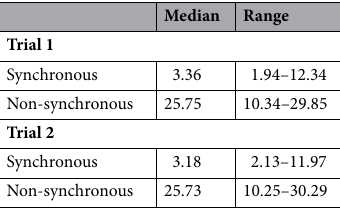
Table 6. Descriptive statistics for the coordination